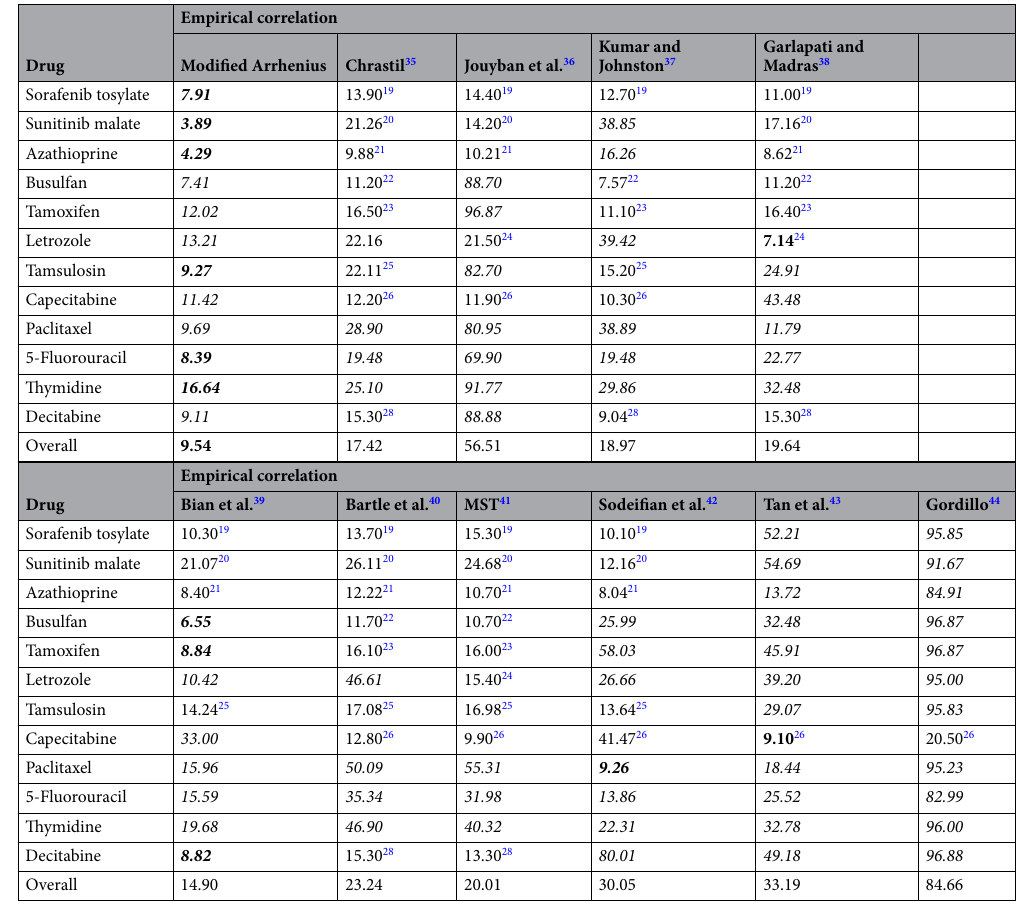
Table 4. Uncertainty of the proposed model and available correlations in the literature in terms of AARD% (the italicized cells are calculated in the current study; the bold font values show the most accurate predictions).